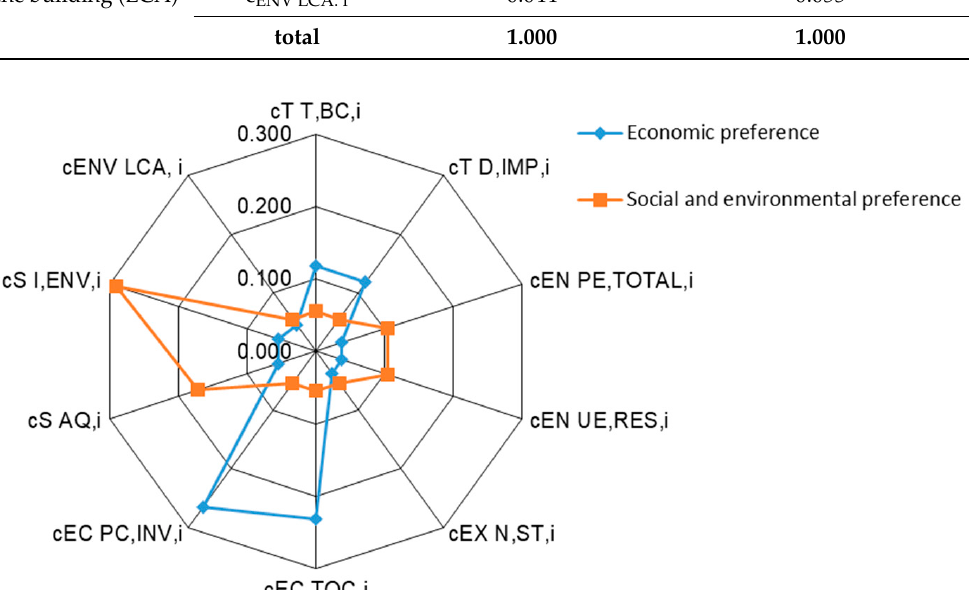
Figure 3. Comparison of the preference weights for the evaluation criteria. The tool, in the form of the AHP/ANP methods, has fulfilled the expected function and made it possible to determine the preference weights for the evaluation criteria depending on the model of the decision-maker’s preferences. It is time to go to the fifth stage of the methodology’s application.